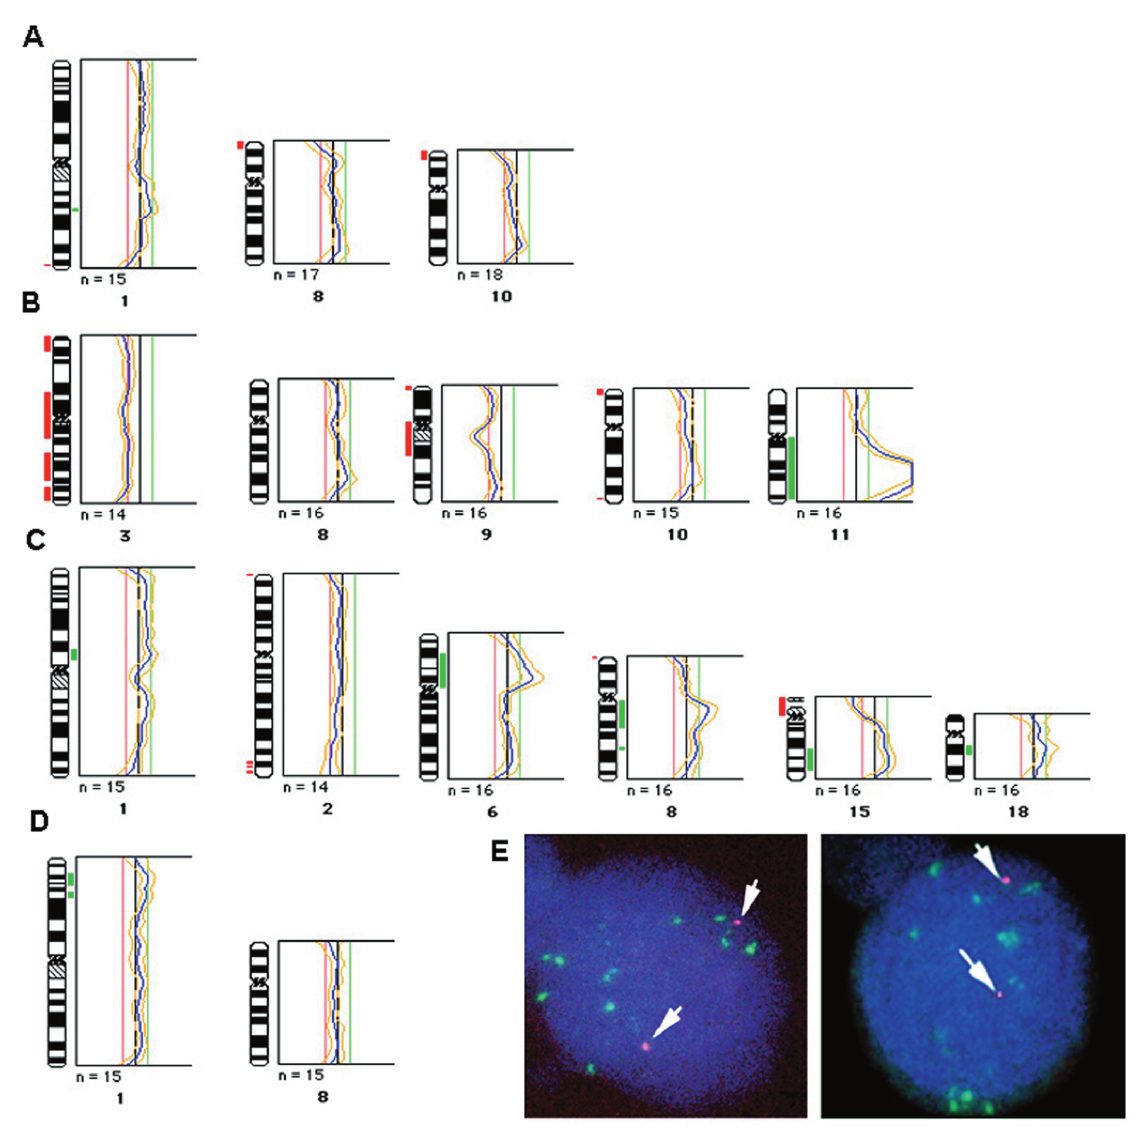
Figure 1 - Graphic representation of the CGH data obtained from three osteosarcomas and one Ewing’s sarcoma. Bars on the right side of each chromo- somedenotegain,andontheleftsidelossofasequence:(A)FMRP2,(B)FMRP3,(C)FMRP4,(D)FMRP9.(E)InterphaseFISHintwoOS(FMRP2and FMRP4) confirming the presence of extra chromosome 8q23.2 sequence (green signals). The arrows indicate two signals for chromosome 8 centromere (red